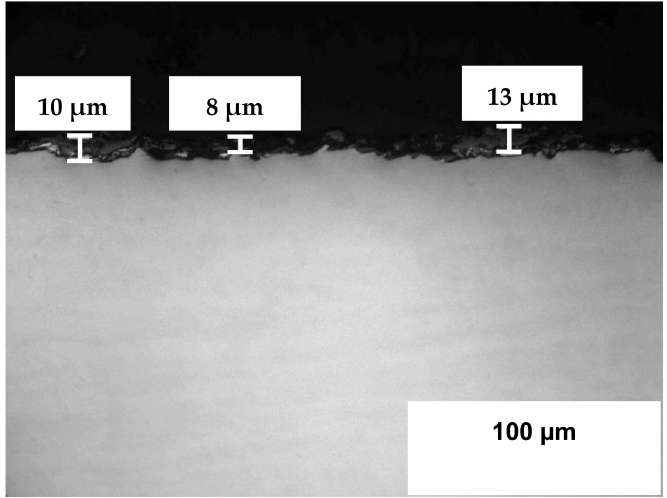
Figure 8. Structure of stainless steel 316L (6) after exposure in H 2 S-air at 500 ◦ C for 504 h.